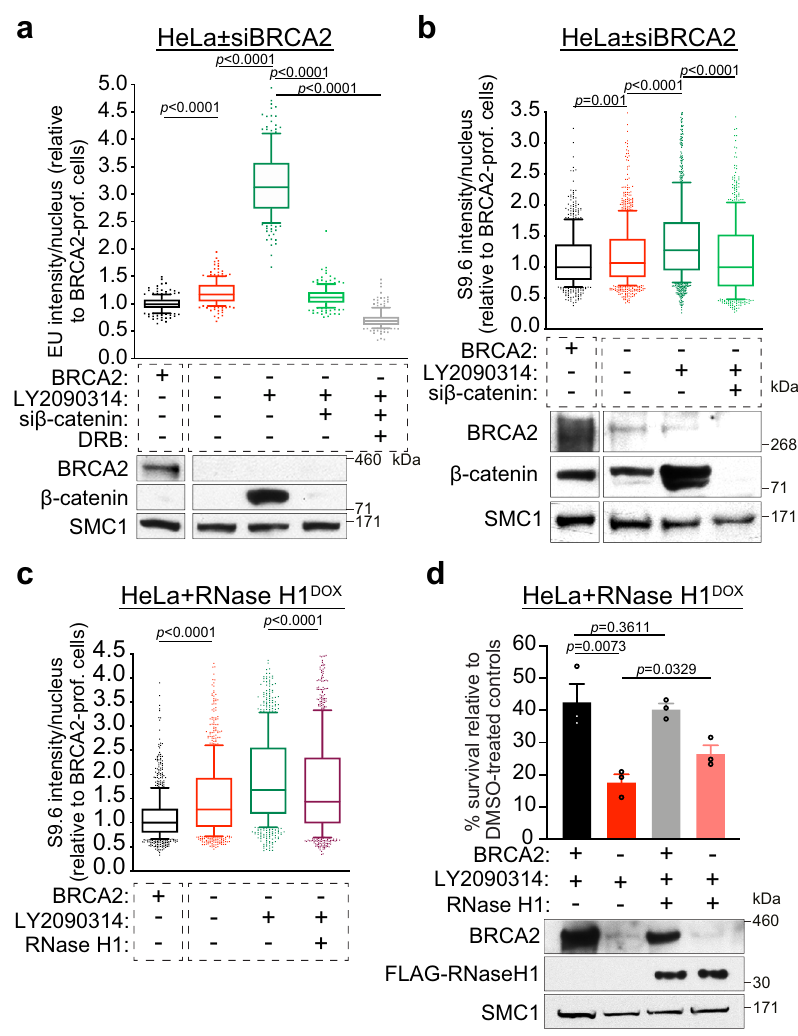
Fig. 6 Oncogenic β -catenin enhances transcription and R-loop formation in BRCA2-de fi cient cells. a HeLa cells transfected with control, BRCA2 or β - catenin siRNAs were grown in the presence or absence of 250 nM LY2090314 for 16 h, with 75 μ M DRB added during the fi nal 2 h as indicated, and pulsed with 1 mM EU for 1 h. Whole-cell extracts prepared from each sample were immunoblotted as shown. SMC1 was used as a loading control. EU incorporation was quanti fi ed as immuno fl uorescence intensity per nucleus ( n = 3 independent experiments; ≥ 200 nuclei analysed per experiment). Boxes indicate the median value and 25th – 75th percentile; whiskers indicate the 10th and 90th percentiles. Statistical signi fi cance was determined by a two-tailed Mann – Whitney test. b HeLa cells carrying a DOX-inducible FLAG-tagged RNase H1 were transfected with control, BRCA2 or β -catenin siRNAs. Cells were treated with 50 nM LY2090314 for 16 h followed by quanti fi cation of S9.6 immuno fl uorescence per nucleus ( n = 3 independent experiments; ≥ 100 nuclei were analysed per experiment). Nucleoli were excluded from the analysis of S9.6 signal. Whole-cell extracts prepared from each sample were immunoblotted as indicated. SMC1 was used as a loading control. Boxes indicate the median value and 25th – 75th percentile; whiskers indicate the 10th and 90th percentiles. Statistical signi fi cance was determined by a two-tailed Mann – Whitney test. c HeLa cells treated as in ( b ) were incubated with 2 μ g/mL DOX to induce FLAG-tagged RNase H1 expression. Quanti fi cation of S9.6 immuno fl uorescence was performed as described in ( b ). d Clonogenic survival assays were performed in HeLa cells treated as in ( c ) and then incubated with 0.1 µ M LY2090314 for 24 h. Survival is expressed relative to DMSO-treated cells. Error bars represent SEM of n = 3 independent experiments. Statistical signi fi cance was determined by an unpaired one-tailed t -test. Whole-cell extracts prepared at the time of cell seeding were immunoblotted as shown. SMC1 was used as a loading control. Source data for ( a – d ) is provided in the Source data fi abnormally high replication rates caused by β -catenin accumu- repressed in cells after β -catenin induction and restored by lation in BRCA2-de fi cient cells are likely to represent a major siRNA-mediated depletion of β -catenin (Fig. 7b). This supported source of DNA damage and an important contributing factor to the concept that β -catenin acts as a repressor of CDKN1A the synergistic effect of oncogene activation and BRCA1/2 transcription, which was consistent with our RNA-seq data abrogation on suppressing cancer cell viability. (Fig. 2a and Supplementary Fig. 5a). To extend the validity of this To investigate the mechanism by which β -catenin accumula- observation in tumours, we analysed mRNA expression data from tion accelerates replication fork progression, we measured the the TCGA collections of breast, ovarian, lung and colorectal levels of CDKN1A gene encoding p21, a modulator of fork speed 4 . tumours. Although the number of samples used in these analyses Expression of CDKN1A , detected by quantitative RT-PCR, was was low, we were nevertheless able to detect an inverse correlation